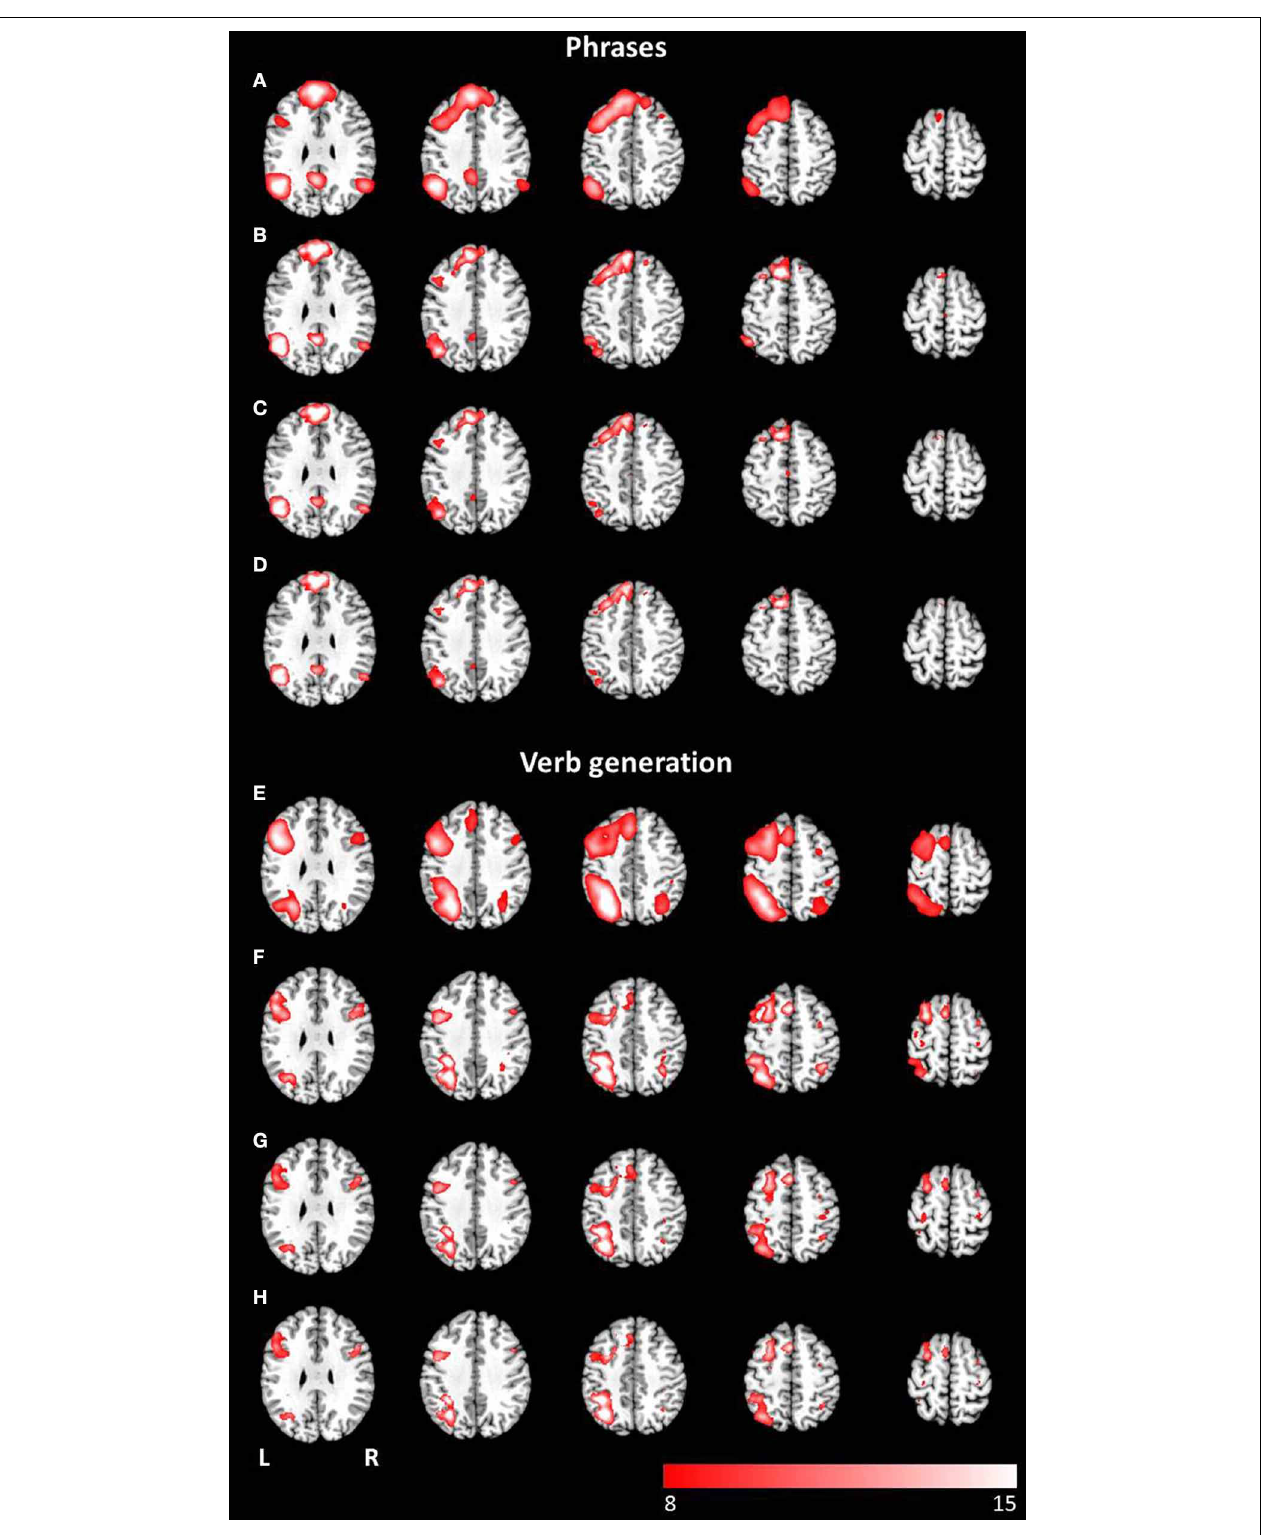
FIGURE 4 | Axial mean anatomical images overlaid with the language network,resultingfromcombinedgroupICAincludingauditoryandvisual stimulus presentation ( p < 0 . 05, FWE-corrected). A network involving language related areas was detected for (A) the phrases task and (E) the verb